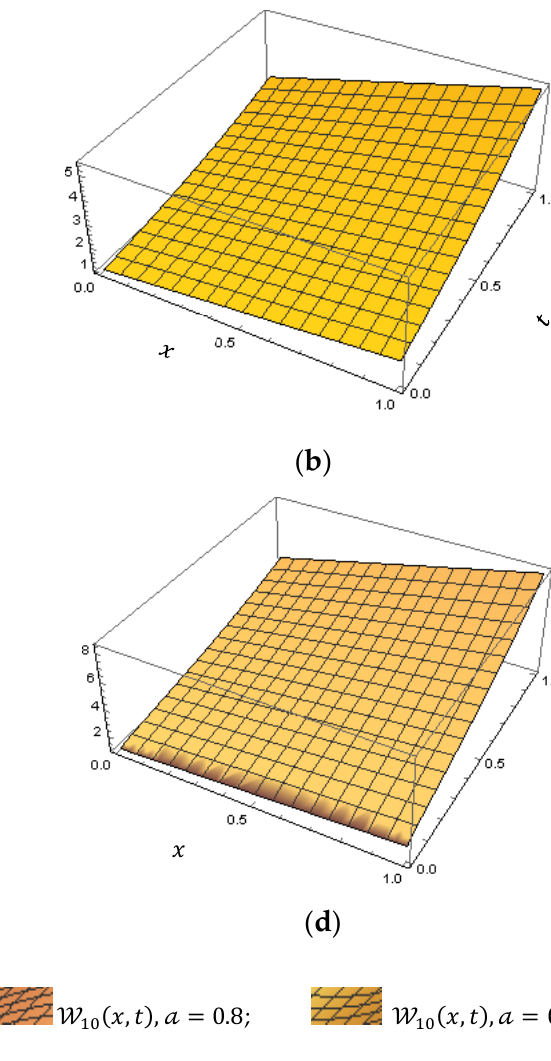
Figure 2. 3D Surface Plots of Exact solution W ( x , t ) , and the 10-th approximate solution W 10 ( x , t ) , for IVP (7), with t ∈ [ 0,1 ] , and x ∈ [ 0,1 ] , at various values of 𝒶 . Table 3. Total computational cost for the obtained figures in Example 1.